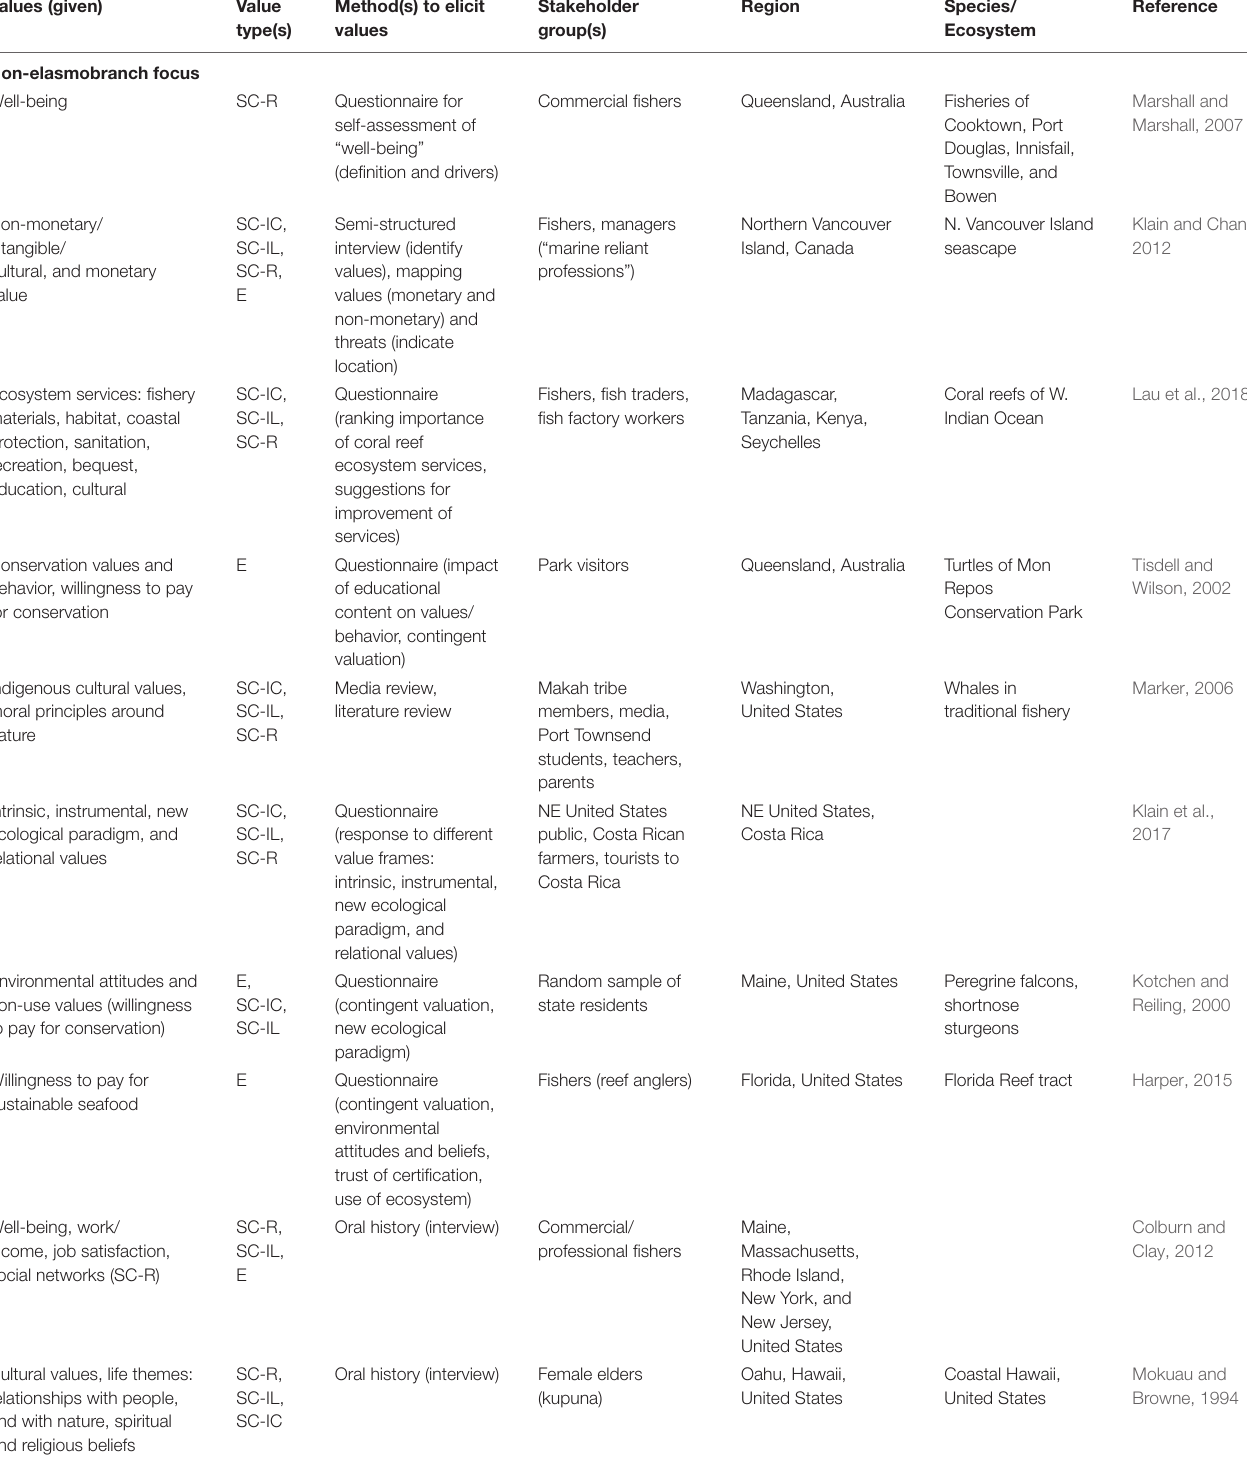
TABLE 3 | Cases from the literature which assessed or described the “value” of elasmobranchs to a community, and/or elicited relational values toward a coastal marine resource. Values